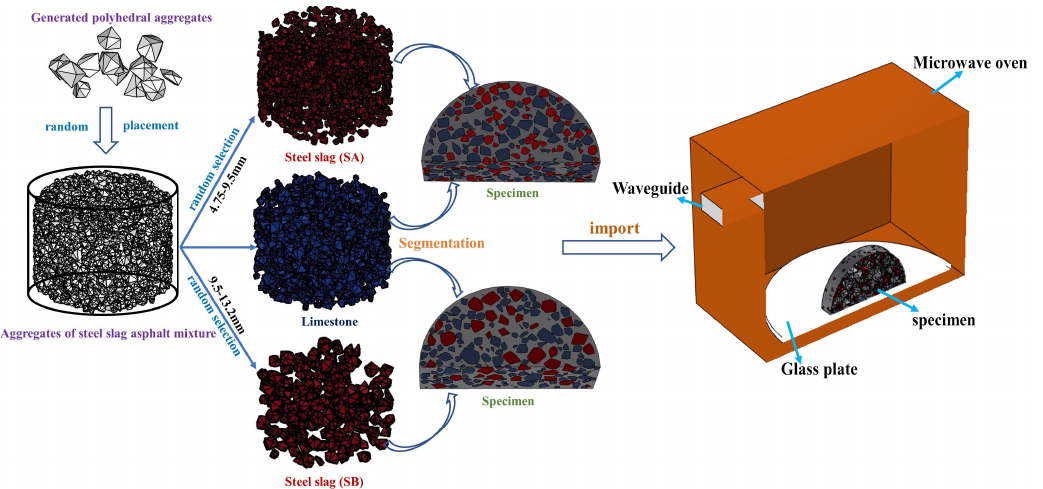
Figure 1. The modeling process of microwave-heating steel slag asphalt mixtures.